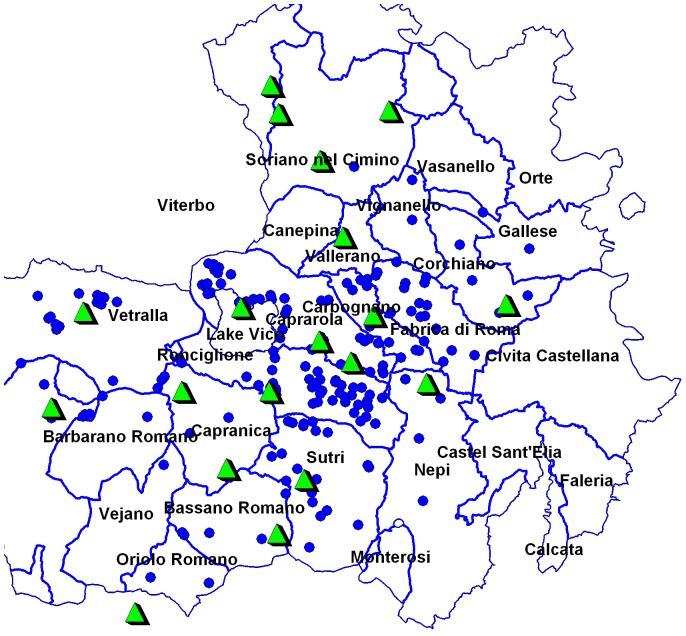
Feature map showing the locations from where pedoclimatic data were collected.Soil analyzed areas (blue beads) and meteorological stations (green triangles) across the hazelnut sites of Viterbo province.